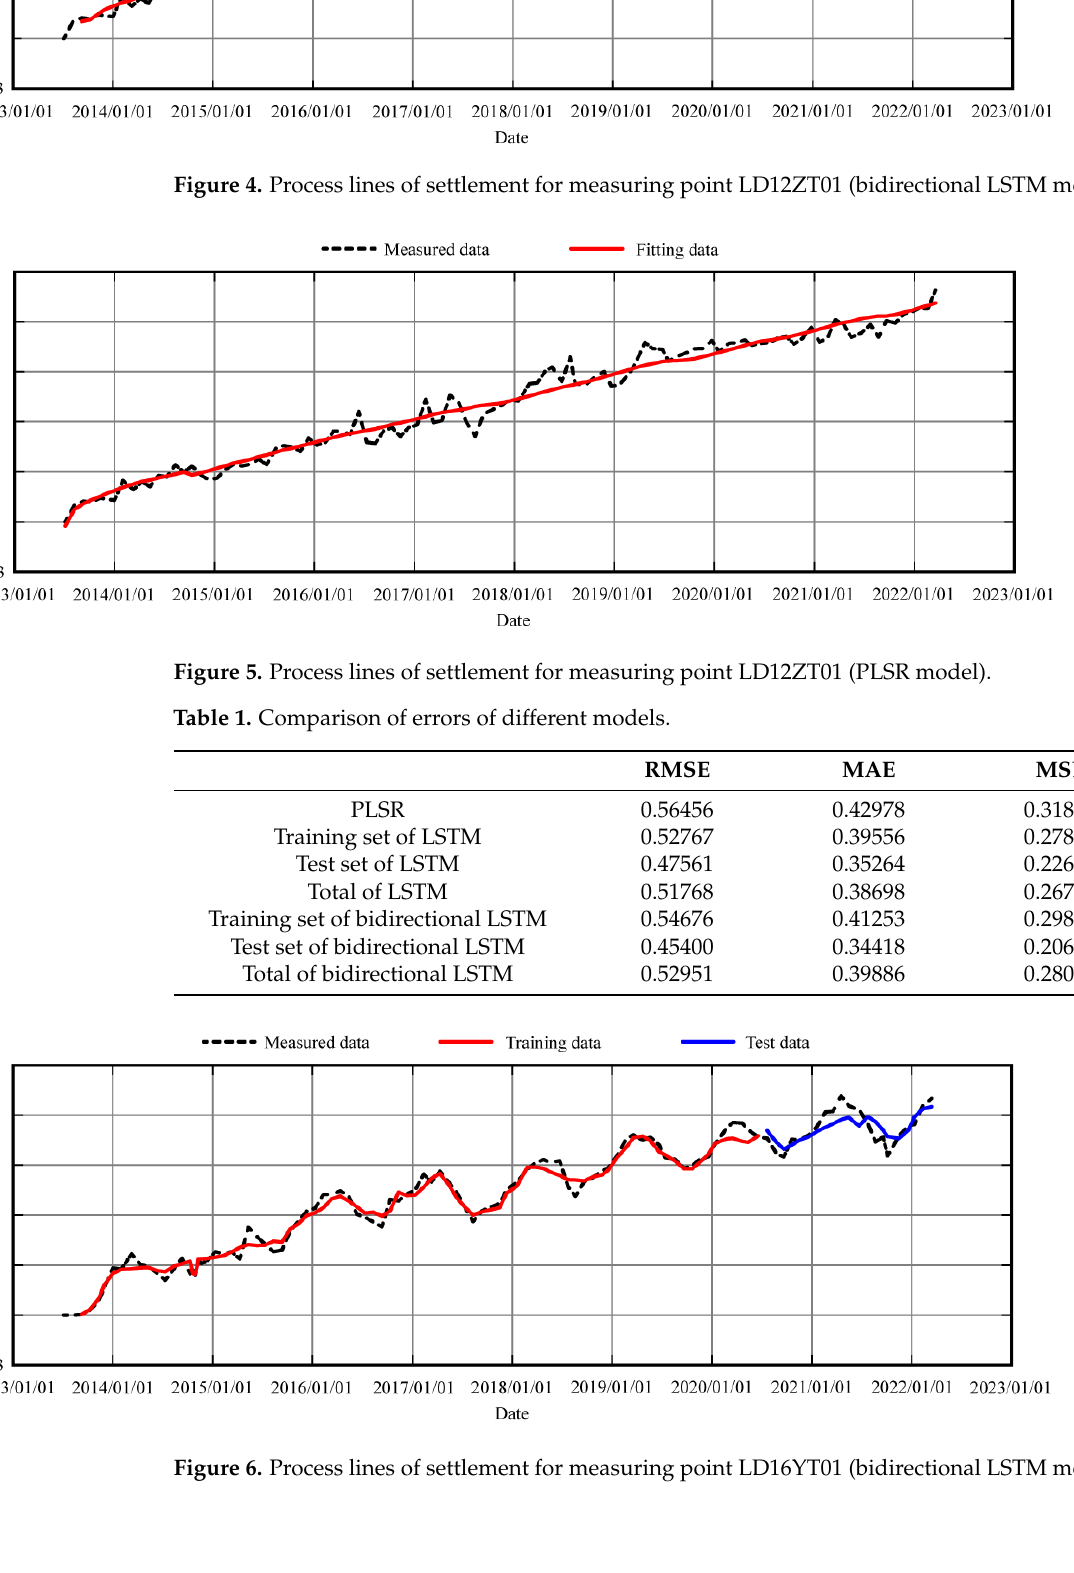
Water 2022 , 14 , x FOR PEER REVIEW